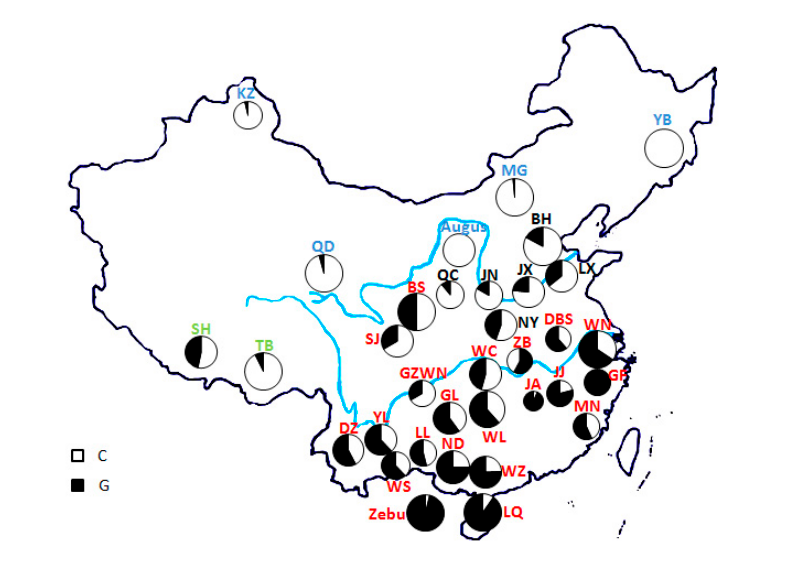
Figure 1. Geographical distribution of NC_037329.1:g.136054902 C > G among 32 Chinese breeds